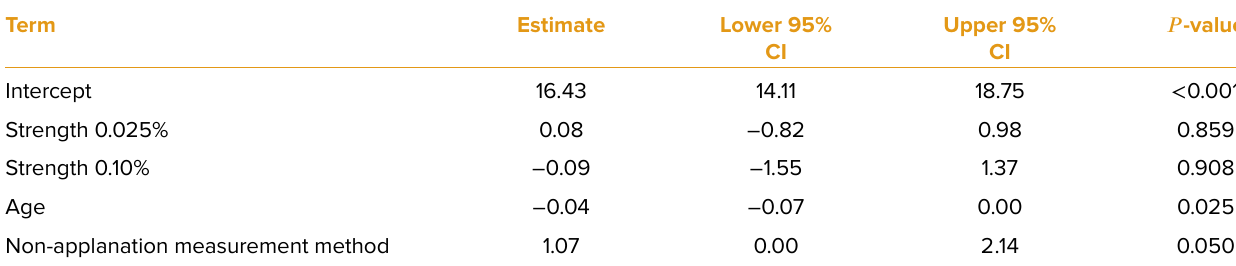
Table 6. Results of regression analysis for IOP with corticosteroid strength as covariate of interest. Term